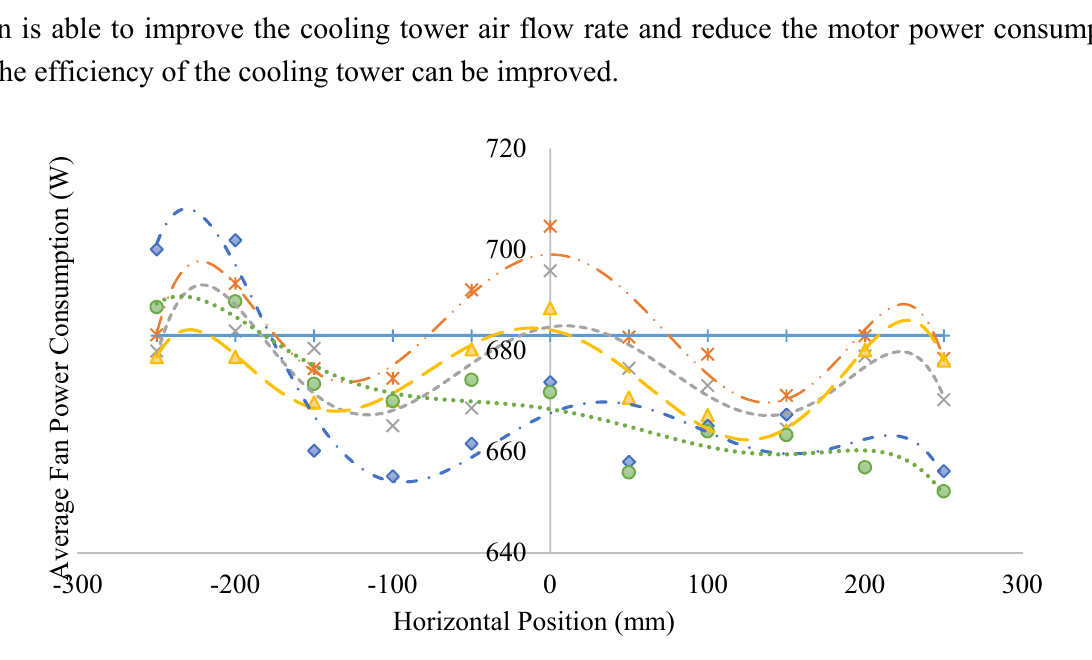
Figure 14. Average fan motor power consumption of the cooling tower model with various